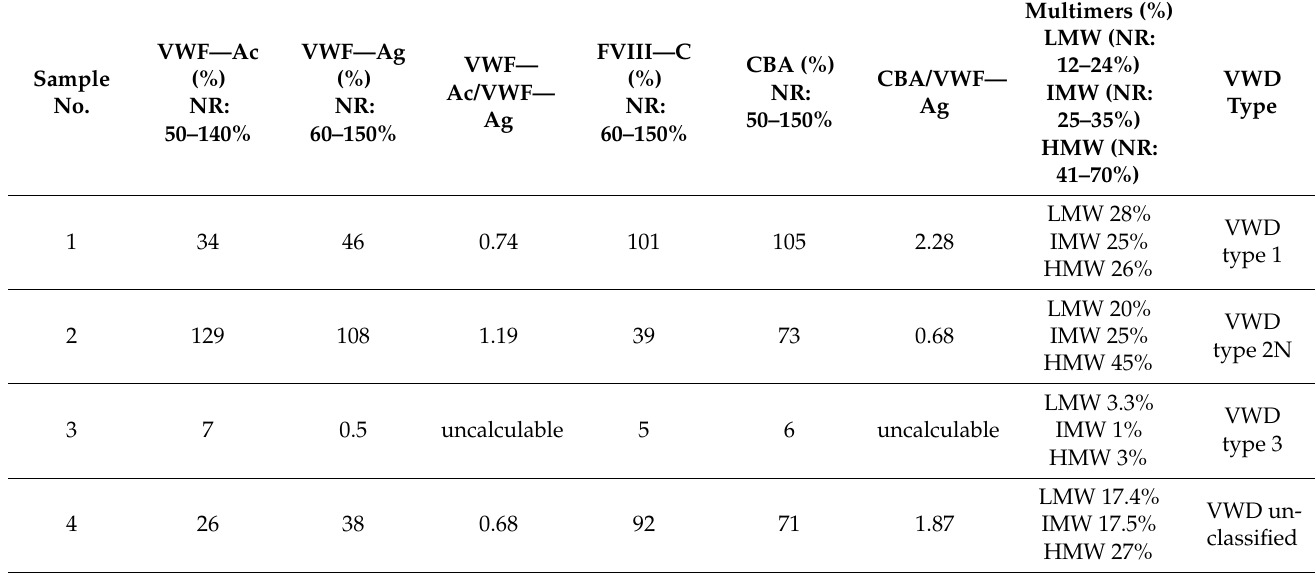
Table 1. Results for patients with VWD type 1, VWD type 2N, VWD type 3, and VWD U (unclassified).